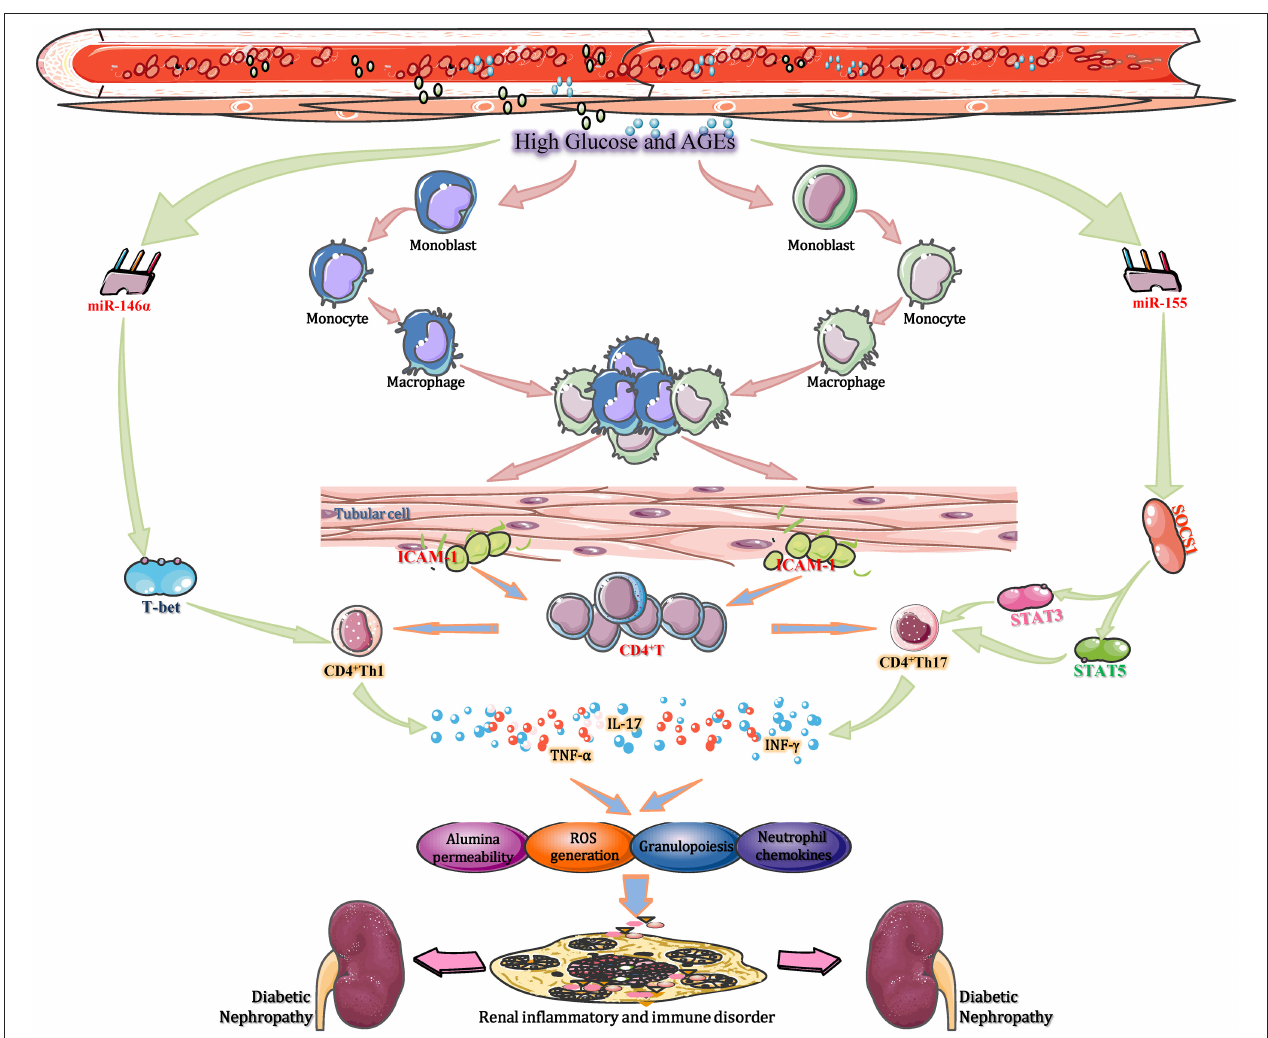
FIGURE 3 | miRNAs regulate T lymphocytes activities to mediate immune and inflammatory processes in DN. During DN progression, miR-155, miR-21, and miR-30b cooperate to promote CD8 + T cell activation by repressing SOCS1, DUSP10, and BCL6, respectively. In TIDN, CD3 + T cells and pancreas-infiltrating T lymphocytes (PILs) are downregulated by miR-202-3p, which affects the pathogenesis of DN. Moreover, miR155-deficient mice showed a reduced CD4 + T cell response to prolong the progression of DN immune disorder. Thus, miRNAs affect DN progression by regulating T lymphocyte-mediated immune functions. BCL6, B-cell chronic lymphocytic leukemia/lymphoma 6; DUSP10, dual specificity phosphatase 10; ICAM-1, intercellular adhesion molecule-1; SOCS1, suppressor of cytokine signaling 1; STAT, signal transducers and activators of transcription; TIDN, type I diabetic nephropathy.